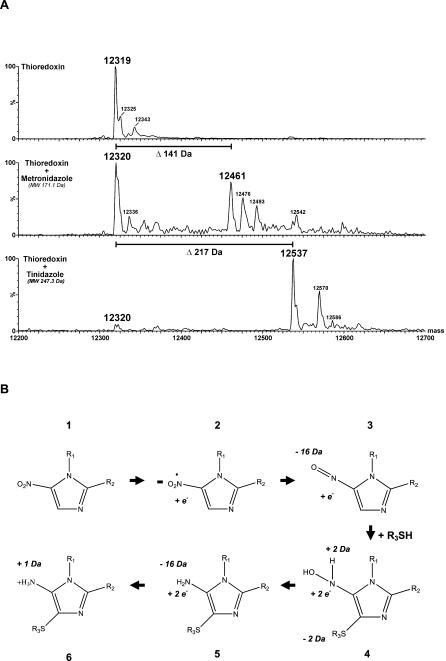
RecEh Trx Increases in Mass upon Modification with Metronidazole or Tinidazole(A) Detection of mass increment by LC-ESI-QTOF-MS. Total protein mass was determined using LC-ESI-QTOF-MS after His-Tag purification of the protein. When BL21 (DE3) cells were not exposed to metronidazole or tinidazole during expression of recEh Trx, a single peak in the deconvoluted mass spectrum was observed. This peak was in good agreement with the expected mass of 12,322 Da when taking into account that methionine at position 1 is removed, six histidines are attached at the C-terminus, and one cysteine-disulfide bridge is formed. When BL21 (DE3) cells were exposed to metronidazole or tinidazole during recombinant protein expression, recEh Trx modified with metronidazole or tinidazole eluted slightly earlier on the LC than unmodified recEh Trx. The determined mass increments, i.e., 141 Da with metronidazole treatment and 217 Da with tinidazole, support the reaction scheme for 5-nitroimidazoles as proposed by Wislocki and colleagues [33]. Additional peaks in the spectra of modified recEh Trx correspond to mass increments of approximately 16 Da or 32 Da, and can be attributed to bound oxygen (a single oxygen or two).(B) Model of adduct formation of 5-nitroimidazoles with sulfhydryl groups. After the uptake of 5-nitroimidazoles into the cell (1), the nitro group is reduced to form a nitro radical anion (2). According to the model of Wislocki and colleagues [33], the nitro radical anion is further reduced (−16 Da) to a highly reactive 5-nitrosoimidazole (3) which forms adducts (−2 Da) with sulfhydryl groups via the C4 of the imidazole ring (4). Adduct formation is accompanied by reduction (2 e−) of the nitroso group to a hydroxylamine group (+2 Da). Subsequently (5), the hydroxylamine group is further reduced (2 e−) to an amino group (−16 Da), resulting in the stable and non-reactive 5-aminoimidazole adduct. At physiological pH or under the conditions applied during MS, the amino group is protonated (+1 Da) (6). A total of six e− is necessary at the nitrogen of the former nitro group to obtain the aminoimidazole adduct which, compared to the corresponding nitroimidazole, decreases in mass by 30 Da. The bound protein or thiol loses one proton during adduct formation. Thus, in total, nitroimidazole adducts gain the molecular mass of the respective nitroimidazole less 31 Da.